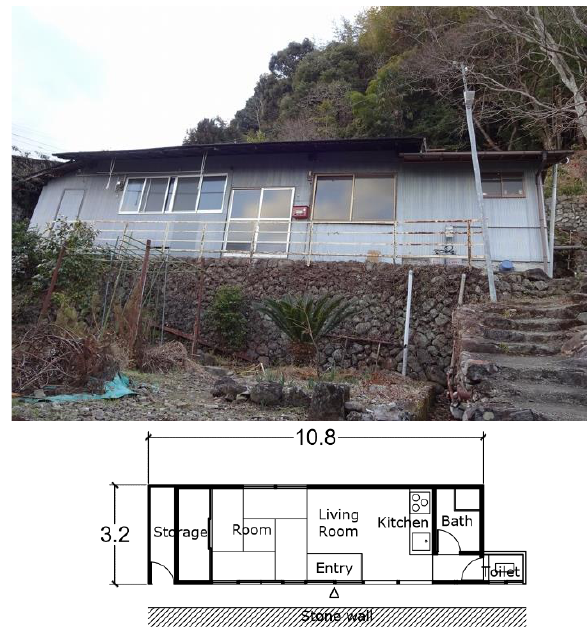
Figure 4. Agariya type A.